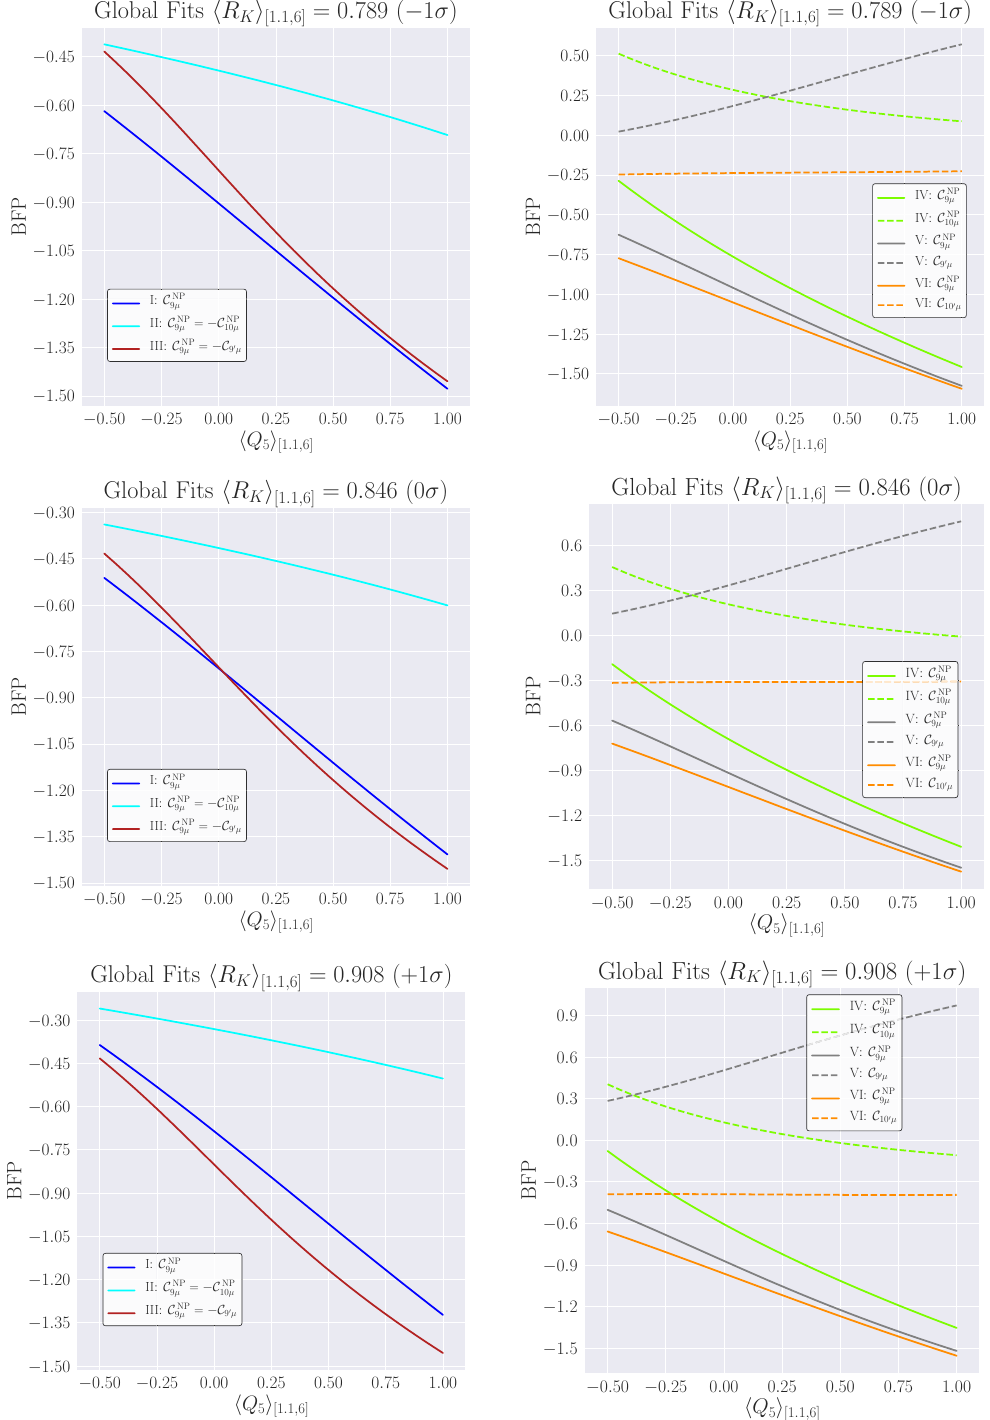
Figure 14. Global fit: impact of for different values of